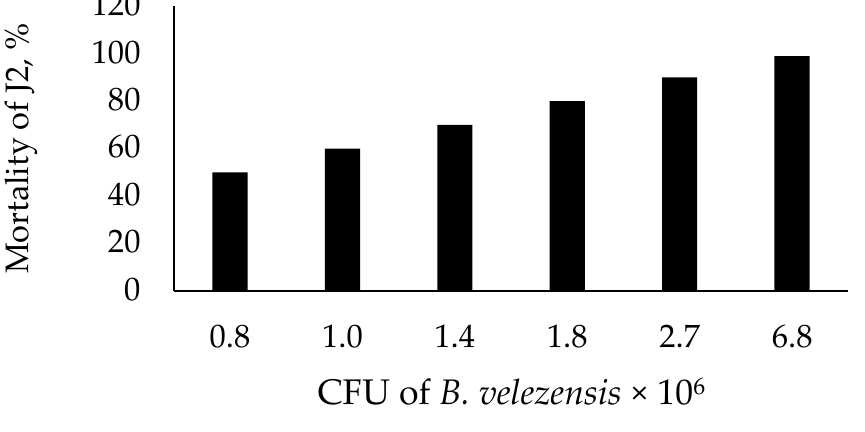
Figure 2. Nematicidal effect of Bacillus velezensis BZR 86 on J2 of Meloidogyna incognita. Its antagonistic activity against F. graminearum, F. oxysporum and R. solani was 45.9%, 32.4% and 45.8%, respectively (Table 1, Figure 3).